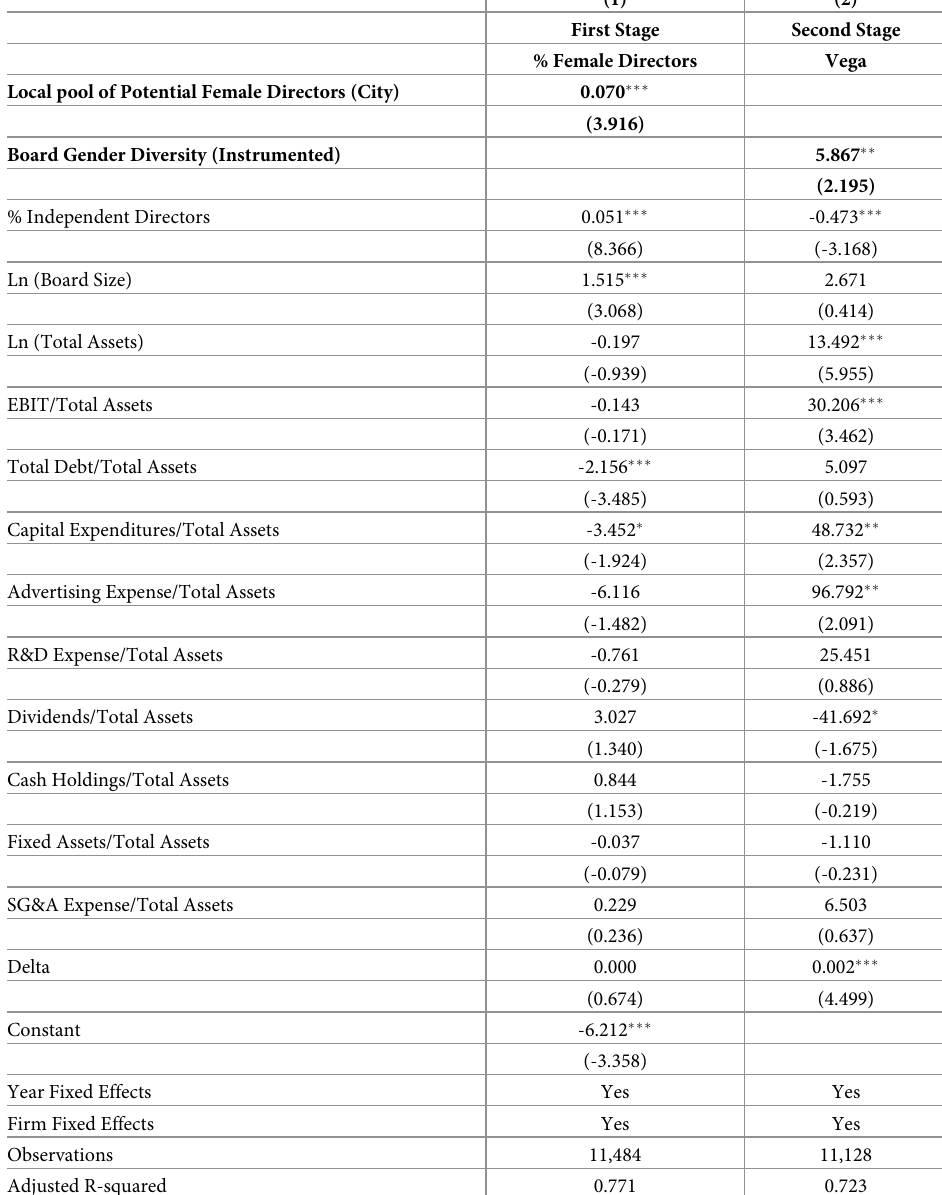
Table 6. Instrumental-variable analysis using a geographic pool of female directors as instrument based on